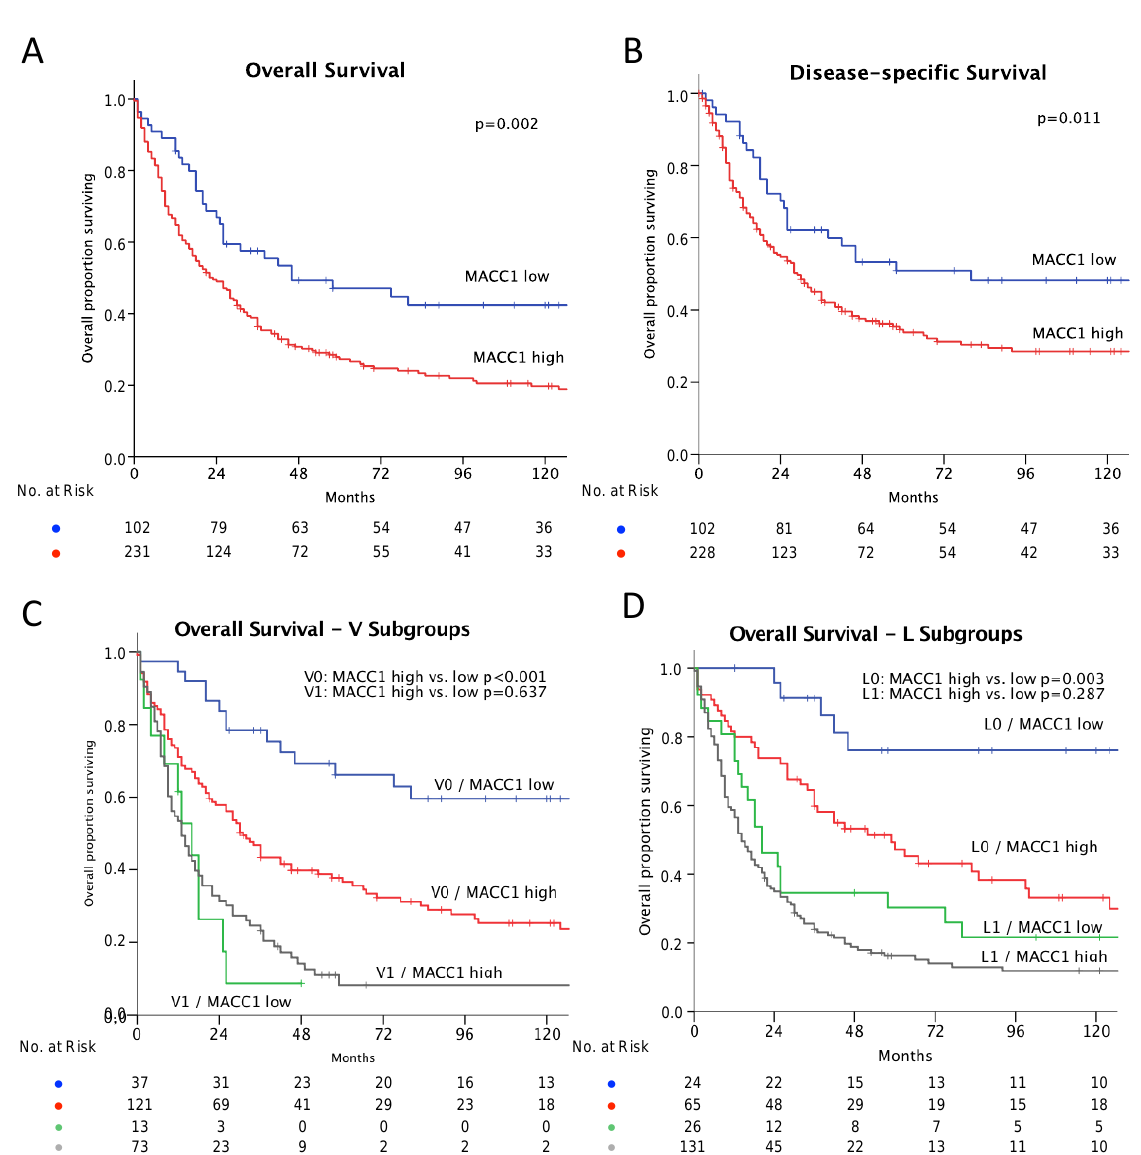
Figure 2. Kaplan–Meier plots of survival, MACC1-low: blue and MACC1-high: red. Significance calculated by log-rank test. ( A ) Overall survival: MACC1-low, better survival, p = 0.002; ( B ) Disease specific survival: MACC-low better survival, p = 0.011. ( C ) Overall survival—subgroup impact of vein invasion. No vein invasion: blue and red as above; MACC-low, better survival, p < 0.001. With vein invasion: MACC1-low: green; MACC1-high: grey; difference not significant, p = 0.637. ( D ) Overall survival—subgroup impact of lymphatic vessel invasion. No lymphatic vessel invasion: blue and red as above; MACC-low, better survival, p = 0.003; With lymphatic vessel invasion: MACC1-low: green; MACC1-high: grey; difference not significant: p = 0.287. Table 2. Univariate and multivariate analysis of patient survival dependent on pathomorphological criteria. Univariate analysis performed by log-rank and multivariate analysis by Cox ’ s regression. Univariate Analysis Multivariate Analysis Median Survival p Odds Ratio Low High p